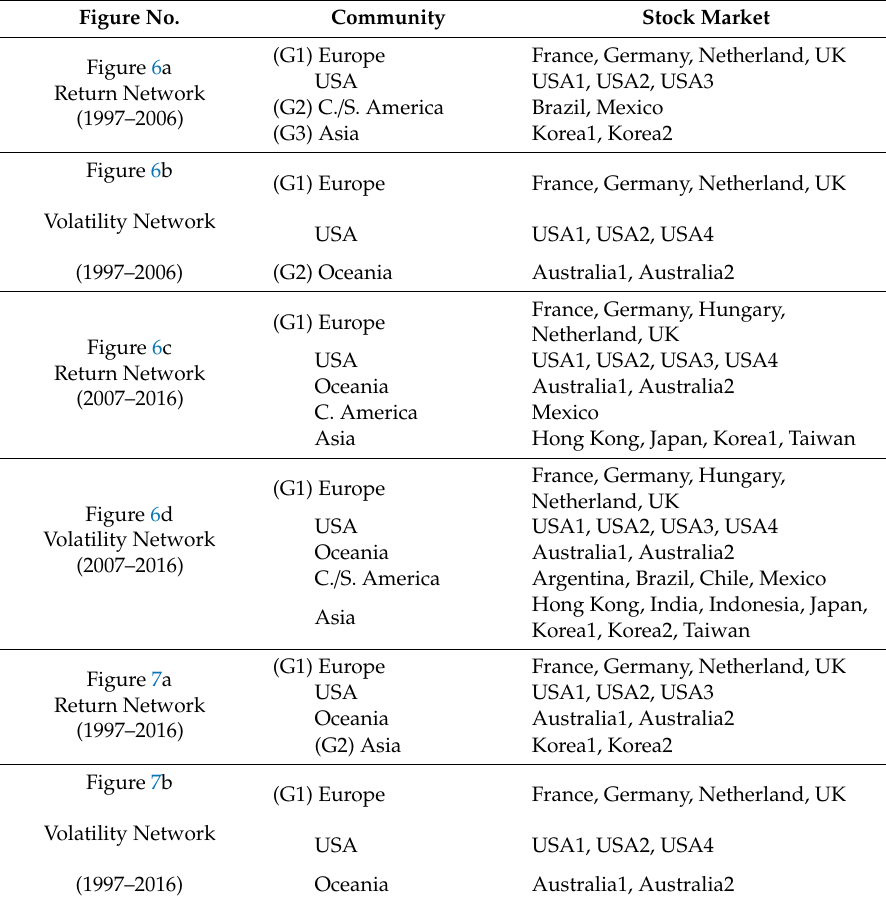
Figure 8 describes macroscopic network properties, i.e., (a) average degree (cid:104) k (cid:105) , (b)